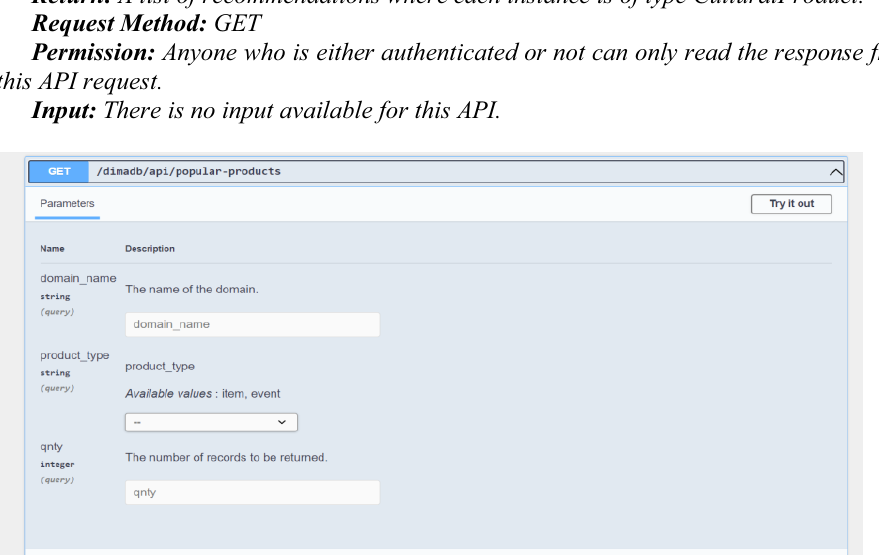
Fig. 9. Popular products recommender